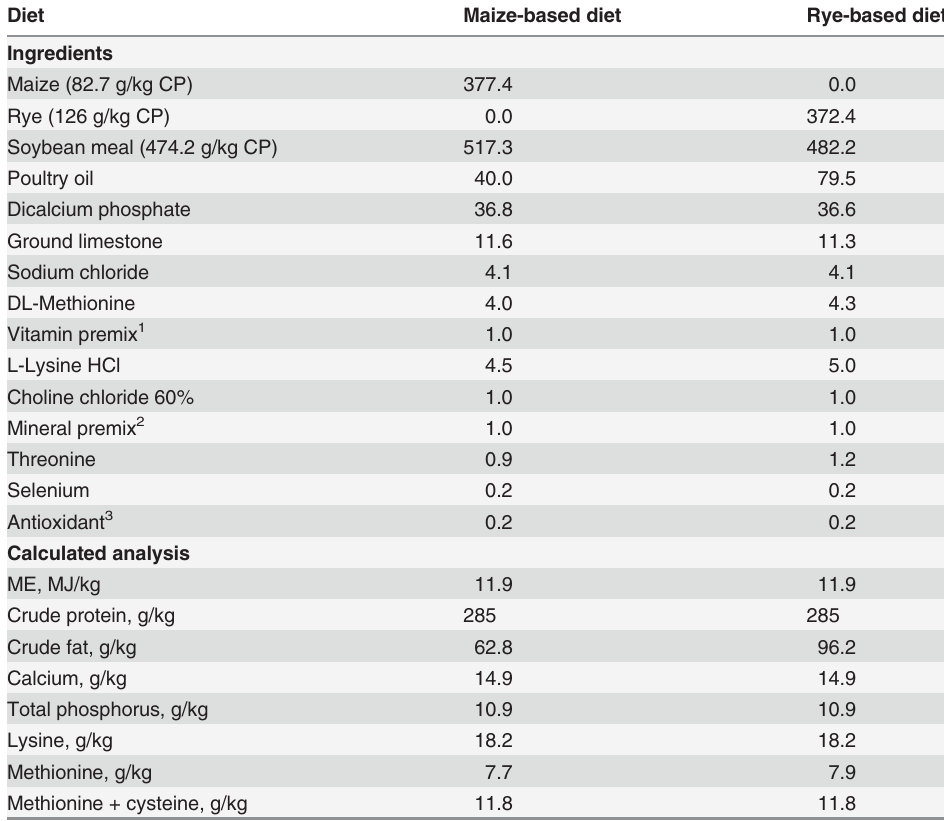
Table 1. Composition of the experimental diets